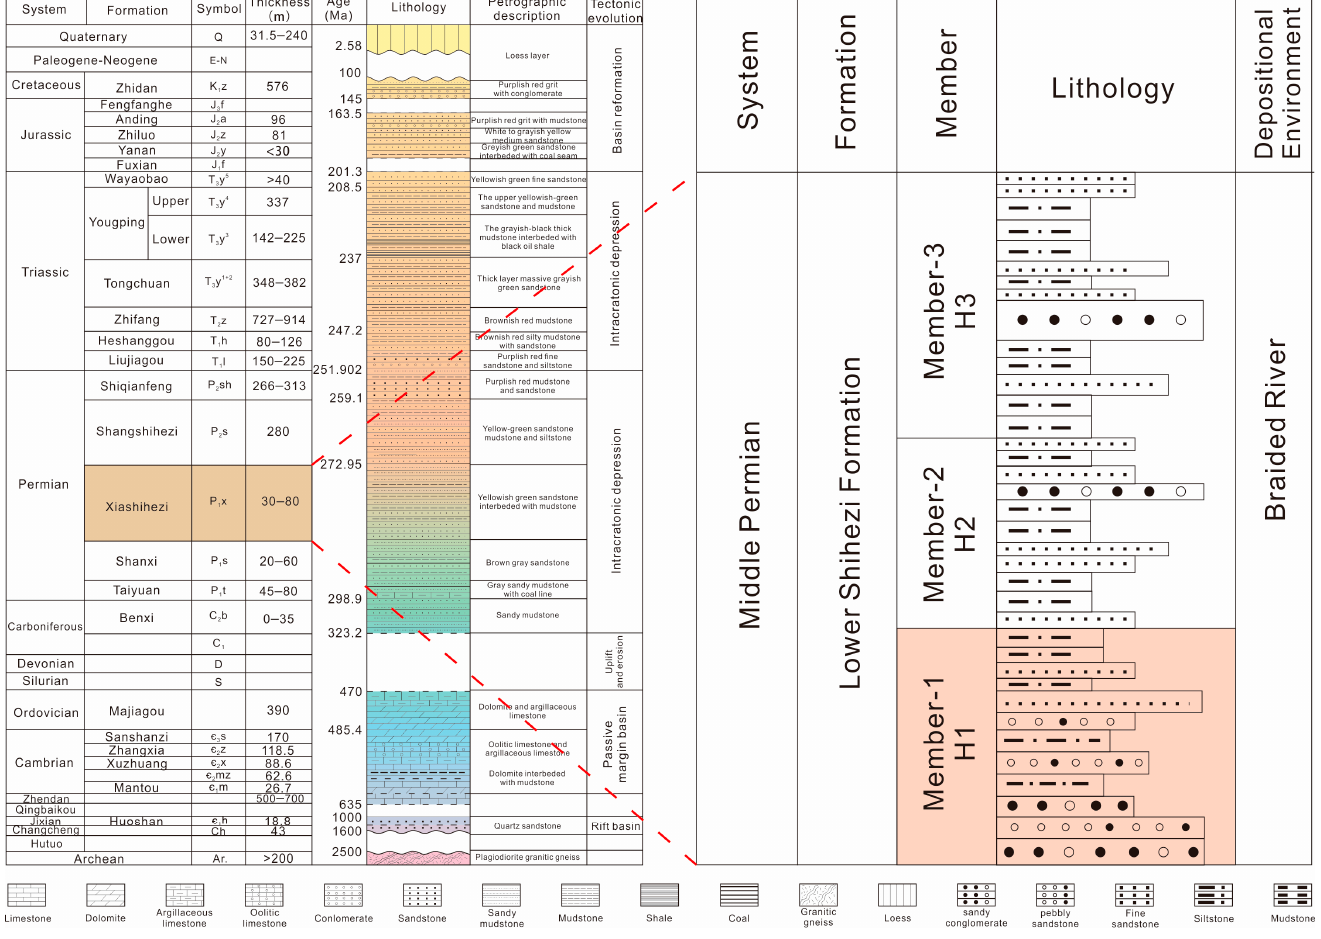
Figure 2. Stratigraphic column of the Shihezi formation in study area (modified from Xu et al., 2022 [38] and Anees et al., 2022